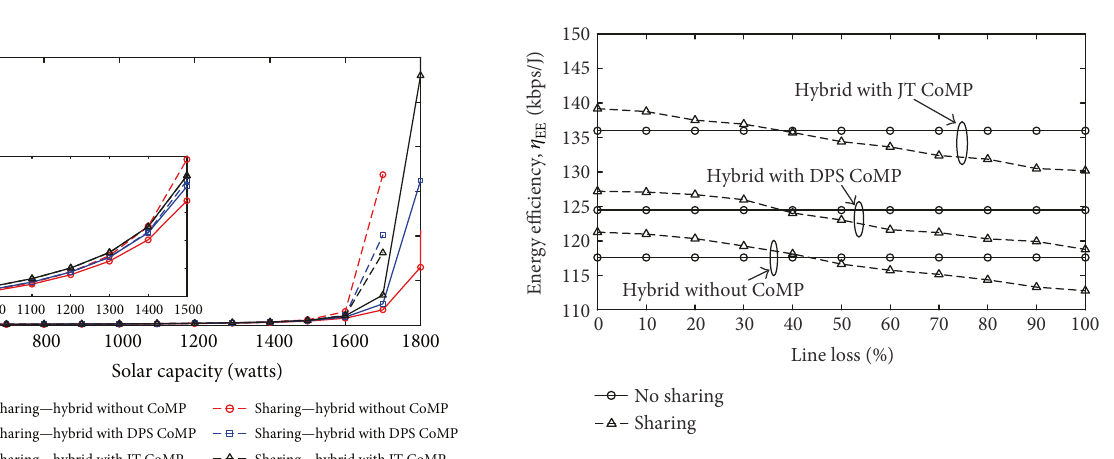
Figure 13: EE with line loss for di ff erent hybrid scenarios with energy sharing under varying solar